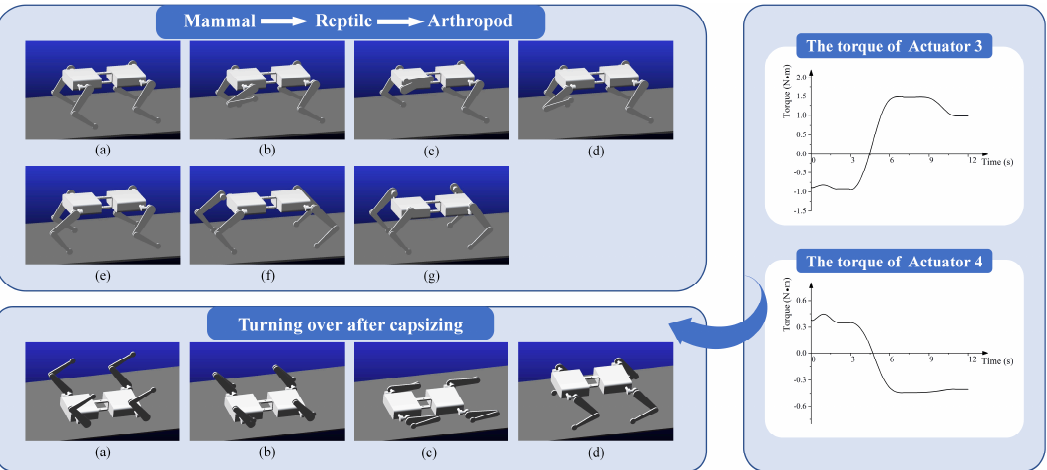
Figure 14. Simulation of the reconfigurable motion and turning over: The figures on the top left show the reconfiguration of the robot; The figures on the bottom left show the robot turning over after capsizing; The right figures show the torque of actuator 3 and 4 in the process of turning over.